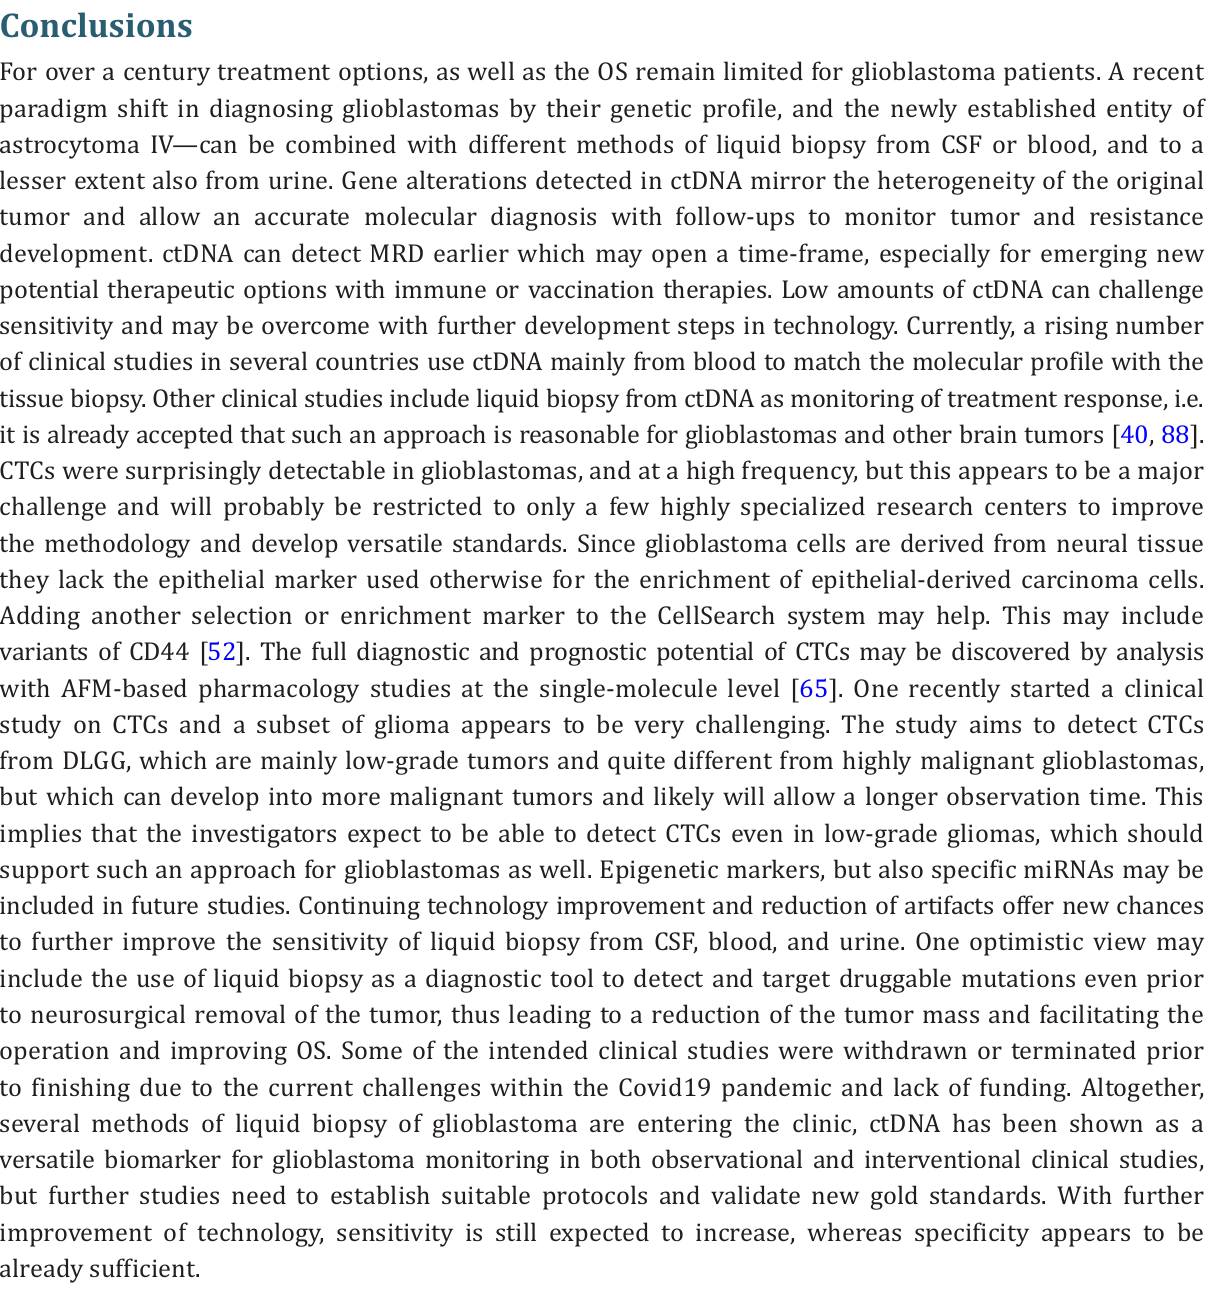
Search for CTCs (> 0), TEP in blood, evaluation of blood-based biomarkers (IDH, 1p19q, ATRX) for diagnosis and